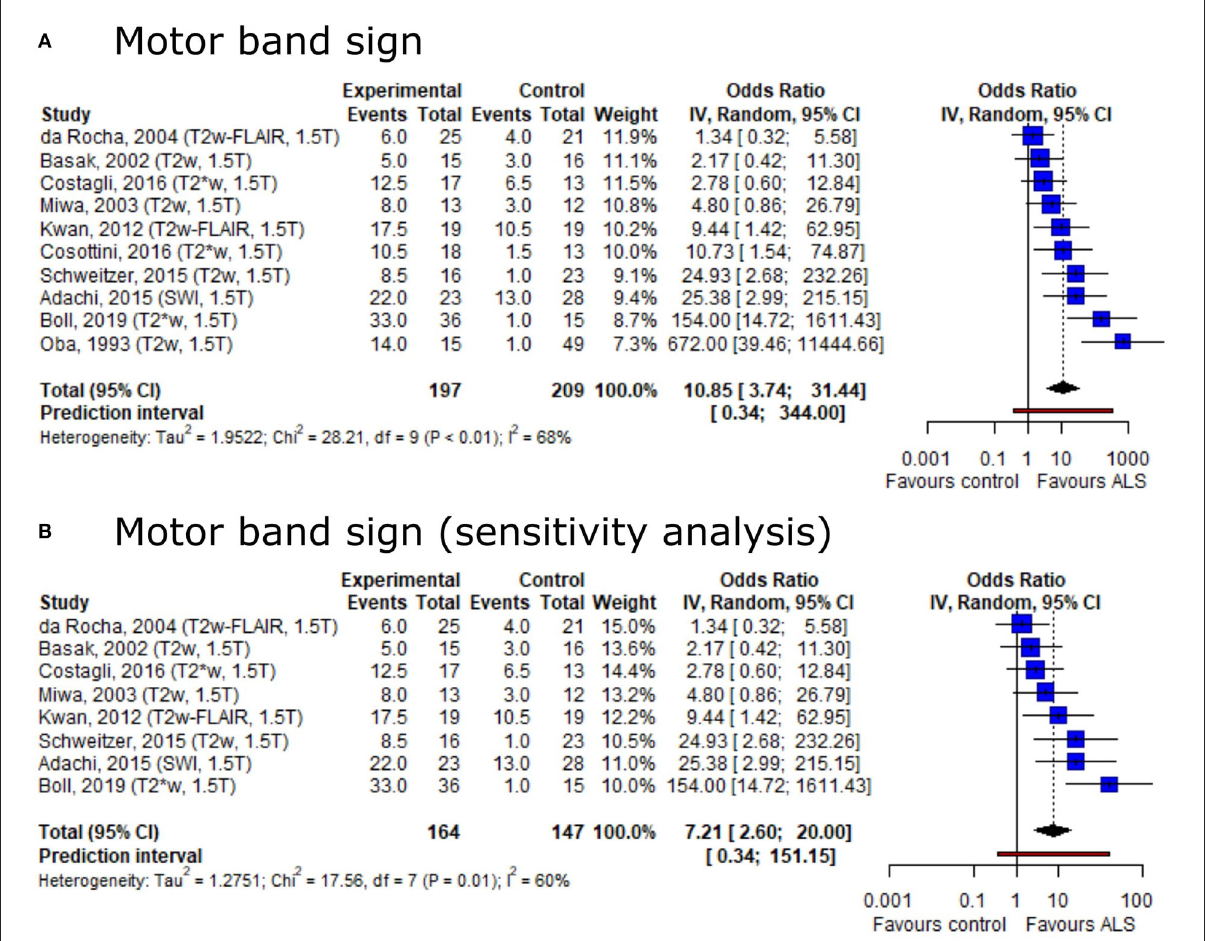
FIGURE4 Forest plot of motor band sign odds ratios among ALS patients vs. controls. Pooled analyses of publications comparing odds ratios (OR) of the motor band sign in ALS patients and controls (A) and a sensitivity analysis only including publications with low risk of bias and comprising healthy controls (B) . Static magnetic field strength for MRI acquisition as well as employed MRI sequence for respective publications are listed in brackets. OR for motor band sign was extracted and pooled using the random effects DerSimonian-Laird method. Dotted line represents study means; black diamond represents overall confidence interval. CI, confidence